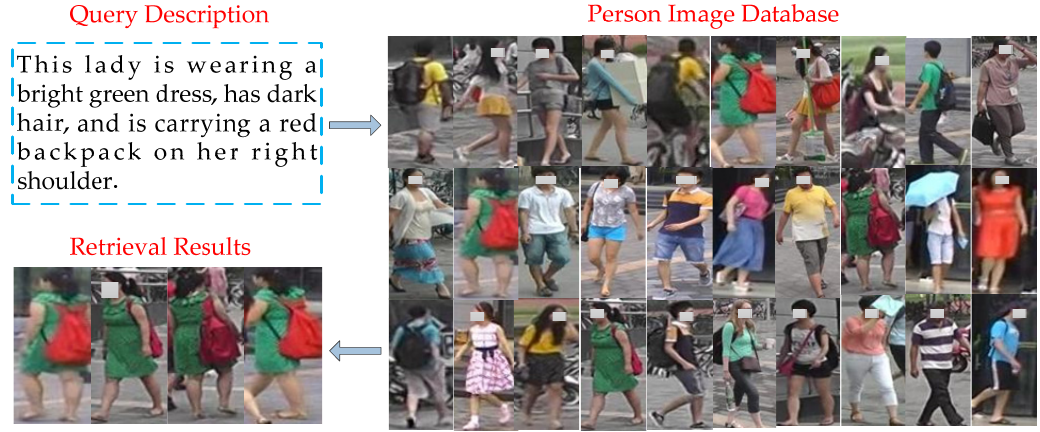
Figure 1. A graphical representation of a natural language-based person search. Provided a language description about the target person, the method retrieves the corresponding person images from the person image database.